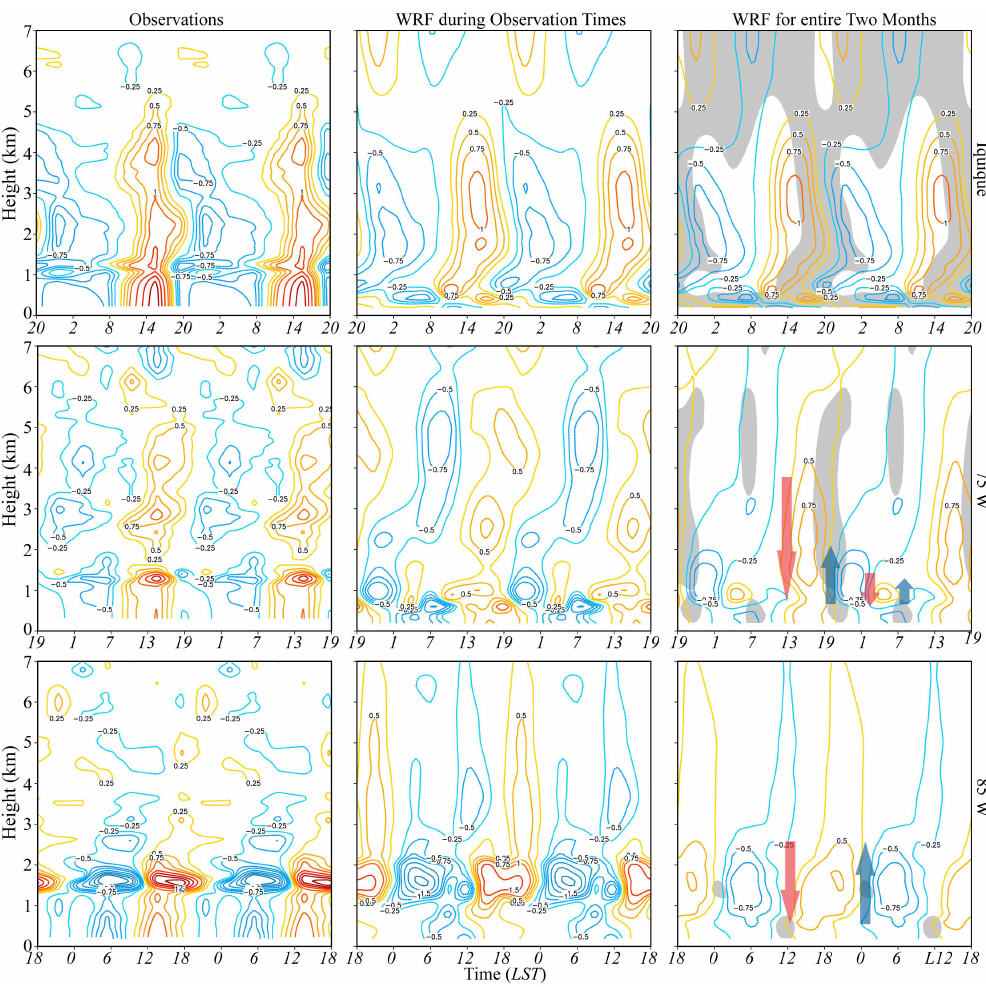
Fig. 14. Comparison of diurnal potential temperature anomalies (contour, K) from the mean state for (left) observations, (center) model simulation at time of observations, and (right) full two month simulation. Shading in the two month simulation figure (right) indicates average upward vertical velocity. The three locations depicted are at Iquique (top), 20 ◦ S, 75 ◦ W (center), and 20 ◦ S; 85 ◦ W (bottom). Arrows indicate vertical